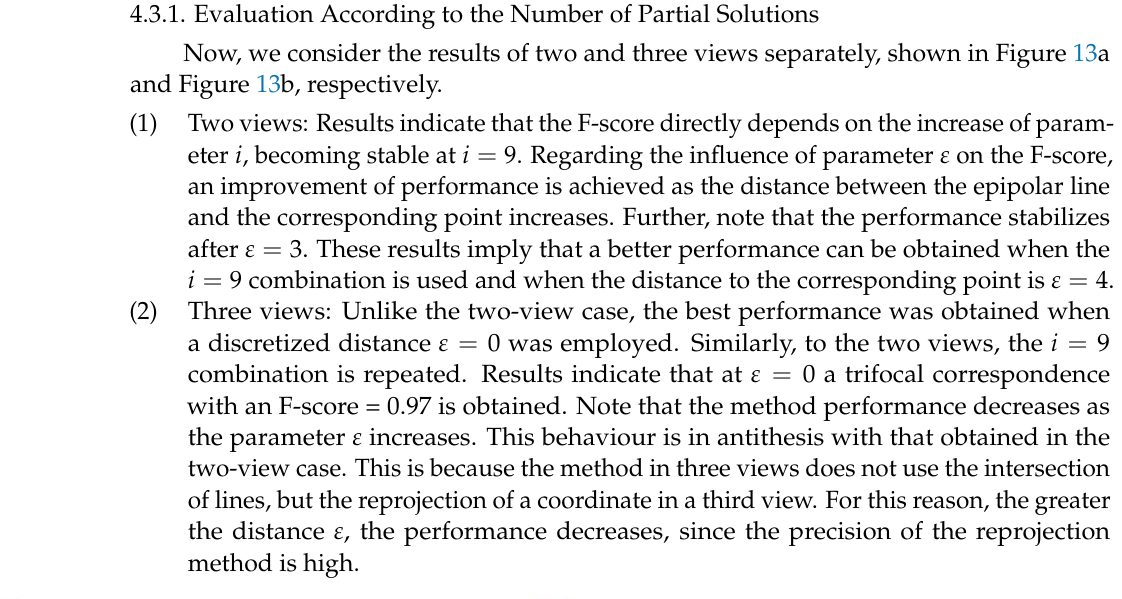
Figure 12. The industrial image set.